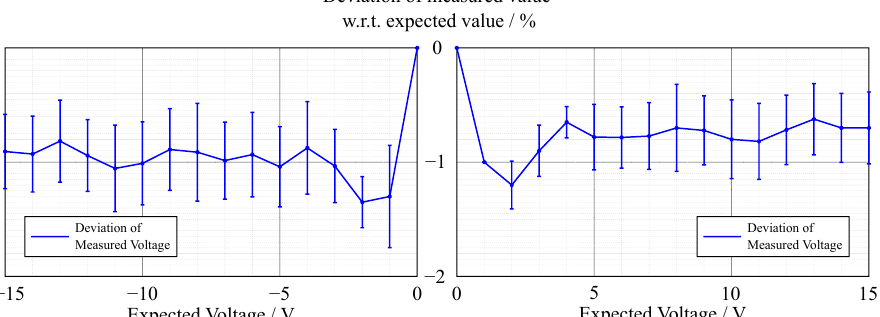
Figure 2. Relative deviation of the voltage as measured by the sensor box with regard to the expected value.